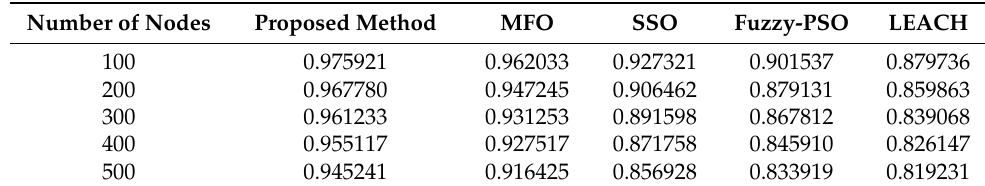
Table 4. Comparison of throughput with various routing protocols.